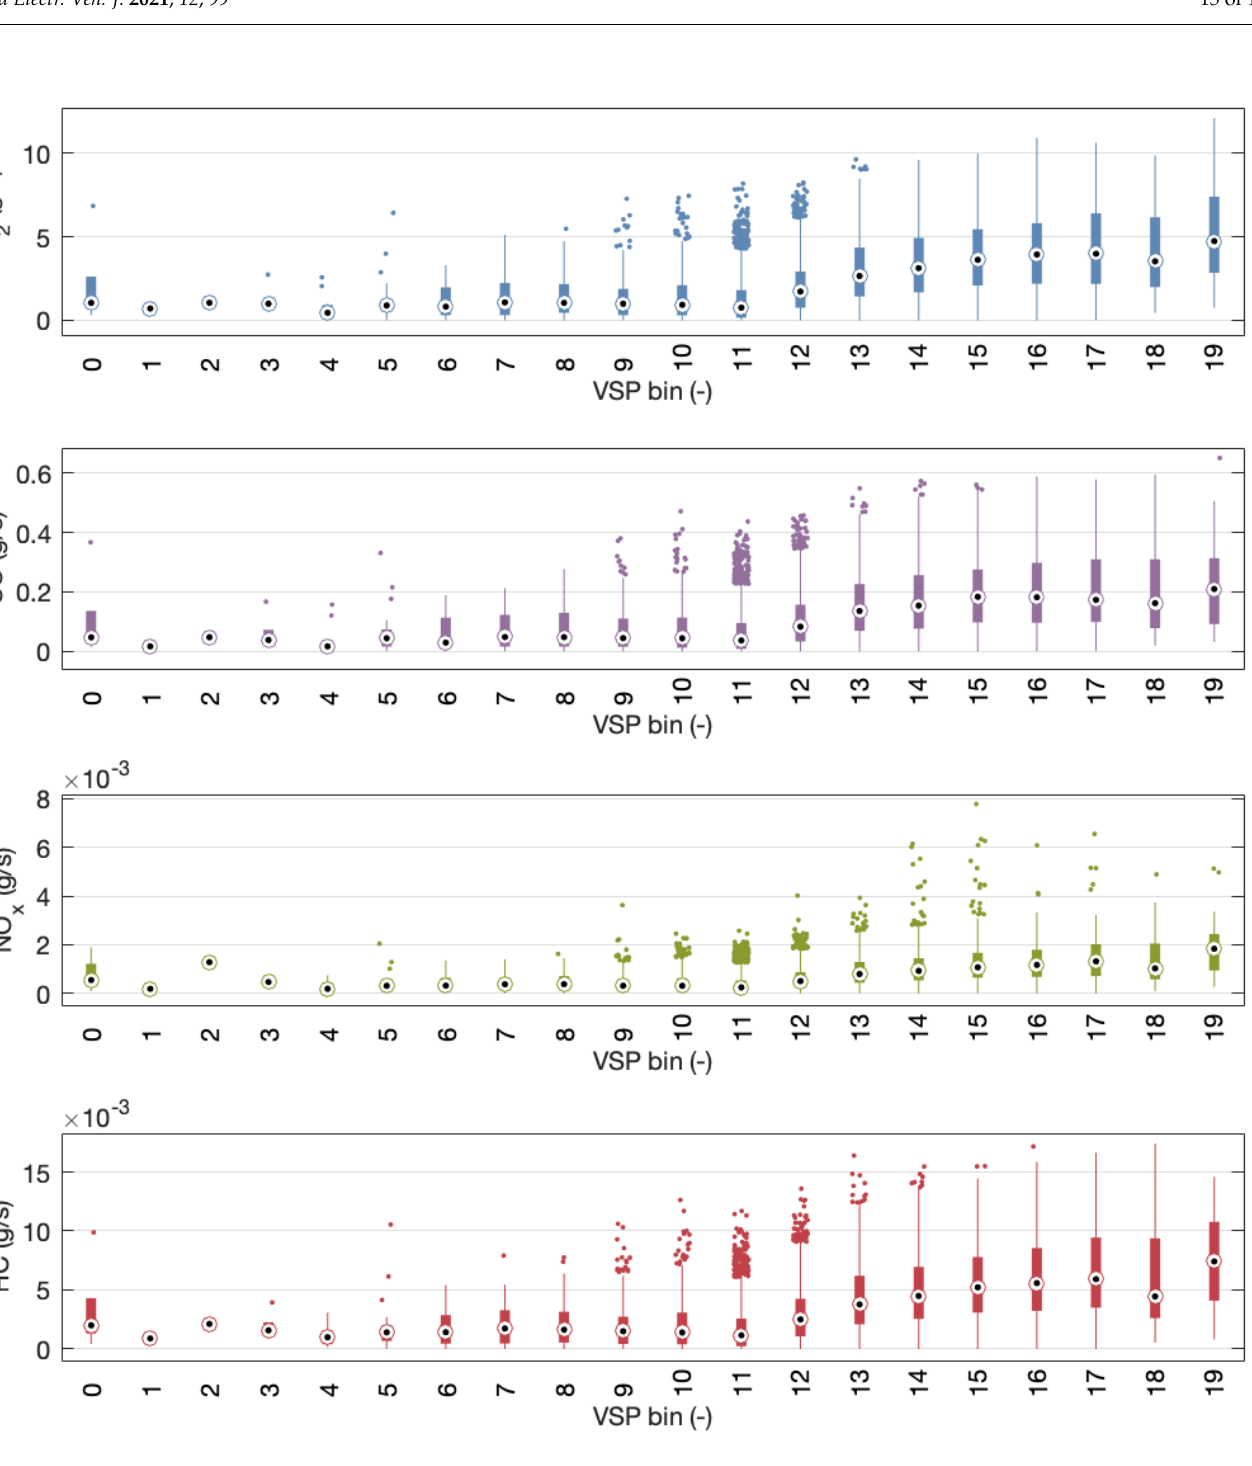
Figure 13. Box plot of mass flow of emissions for test carried out with gasohol E10. Finally, based on the box plots shown above, a comparison of the behaviour between E7.8 and E10 was made (Figure 14). The values chosen for comparison were Q 1 (25th percentile), the mean, and Q 3 + 1.5 IQR, which corresponds to the maximum representative value of the